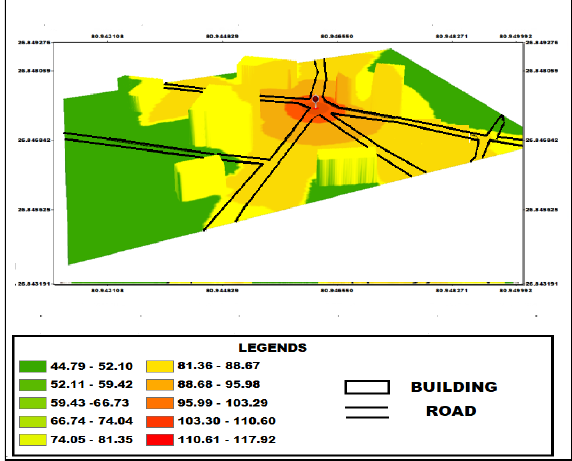
Figure 12. The instantaneous noise level has been measured and plotted in a 3D noise map of Hazartganj Intersection with values ranging from 44.79 to 117.92 dB(A) from a single point source. The attenuation of barriers and distances is also estimated and